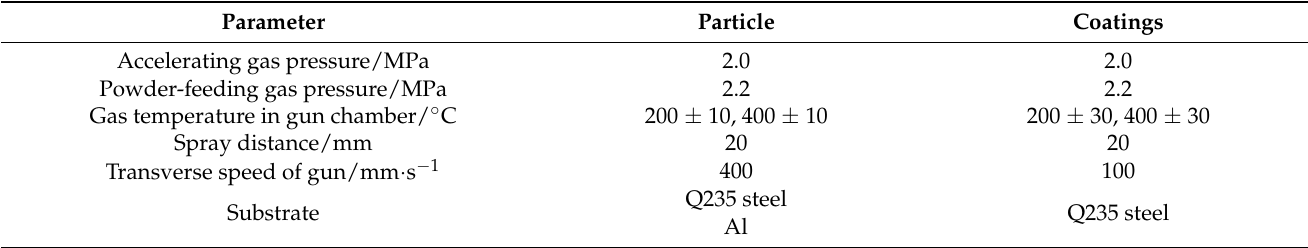
Table 1. The parameter details of cold spraying Ni-coated Al particle and coatings.